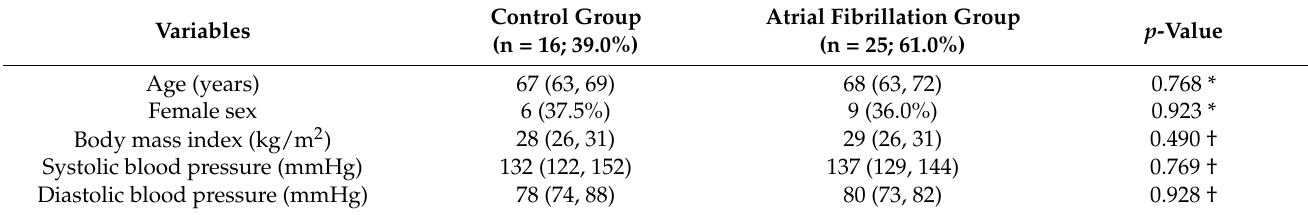
Table 1. Comparison of baseline characteristics between the study